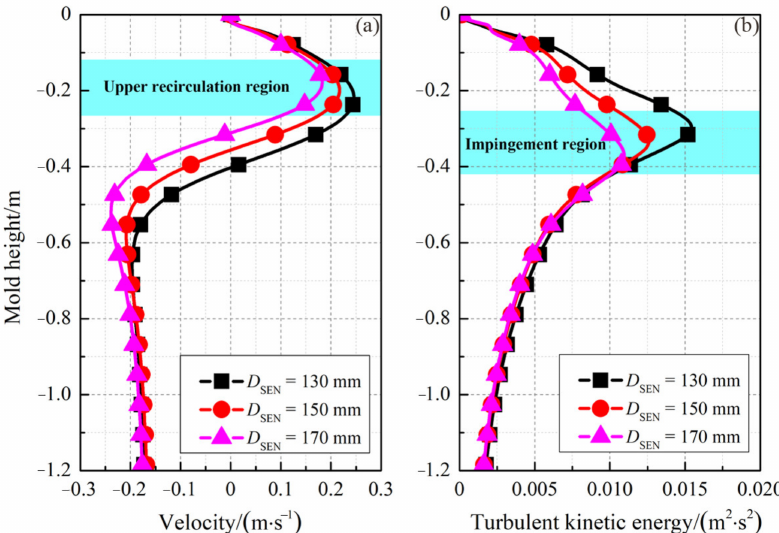
Figure 11. Velocity and turbulent kinetic energy profiles along mold height direction ( X = 0.695 m, Y = 0 m) with ruler EMBr under different SEN depths: ( a ) vertical velocity and ( b ) turbulent ki- netic energy.